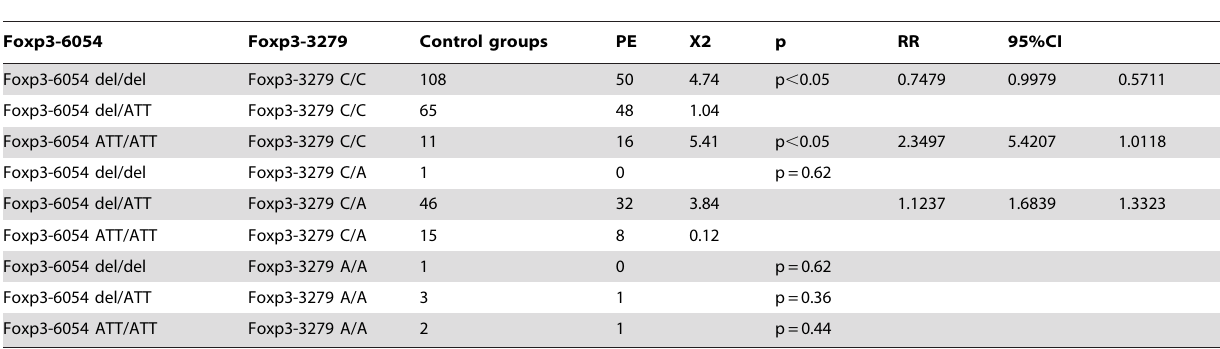
Table 5. Foxp3-6054/ 2 3279 haplotype frequency in PE and Control